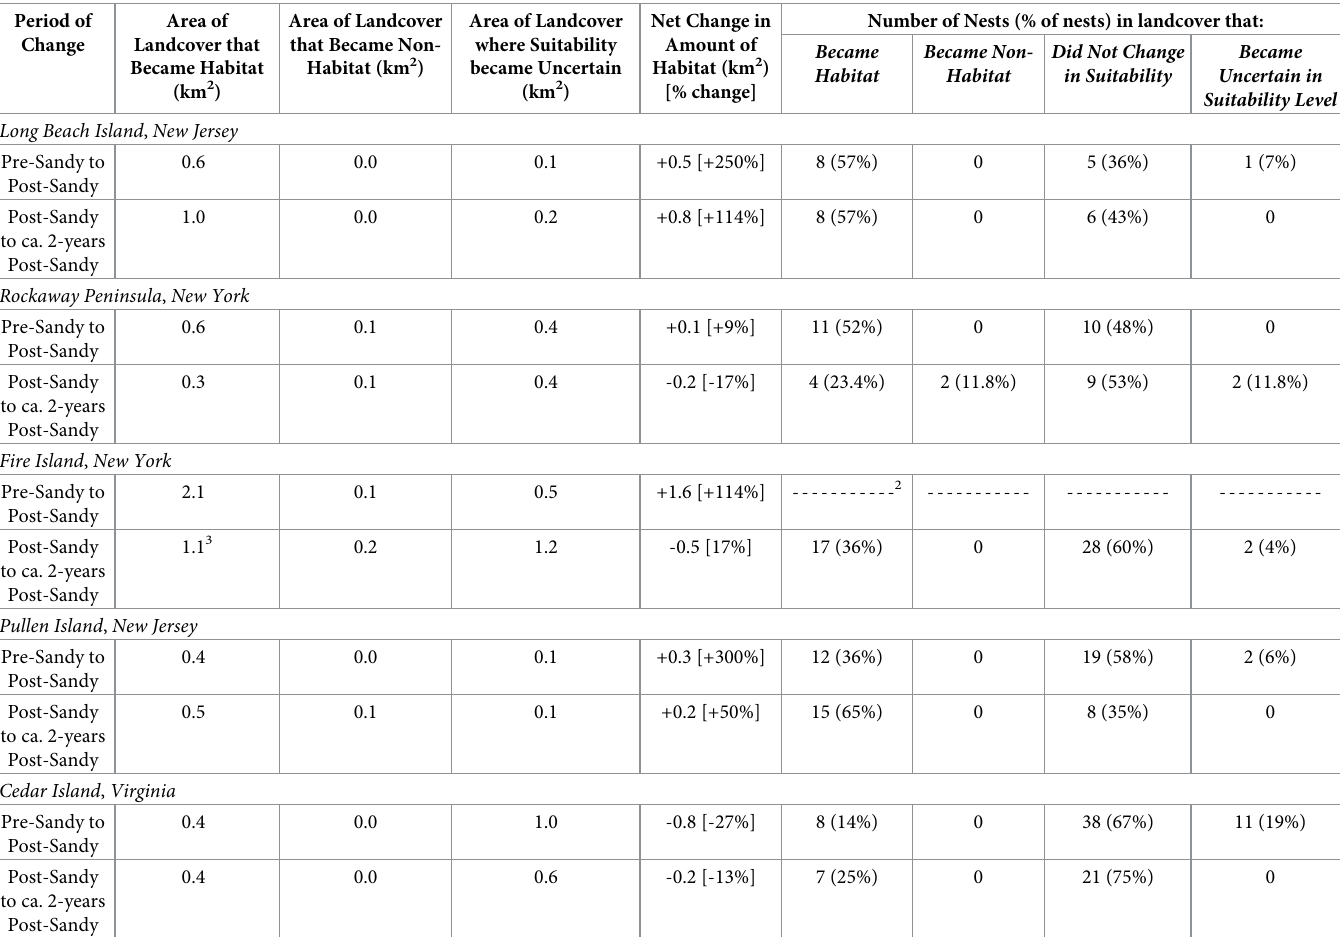
Table 3. Changes in piping plover habitat availability 1 for landcover conditions present before Hurricane Sandy, immediately following Sandy, and ca. 2 years post- Sandy at study areas in New York, New Jersey, and Virginia USA. For reference, we indicate the number of nests that were established in habitat where landcover became habitat, became non-habitat, did not change in suitability, or became uncertain in suitability level between the pre-Sandy to post-Sandy (nests: 2013 breeding sea- son) and between the post-Sandy and ca. 2-year post-Sandy (nests: 2014/2015 breeding season) study periods. Sites are listed in decreasing level of human